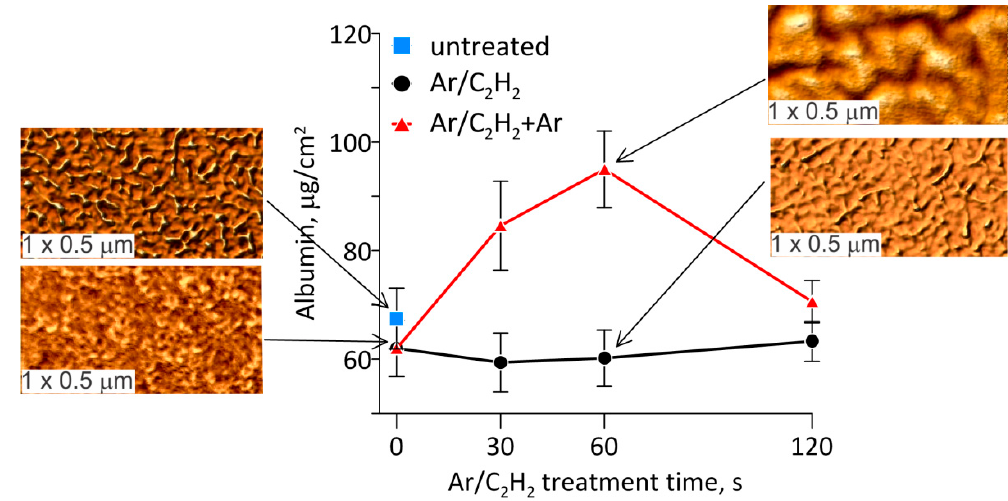
Figure 5. Sorption activity of albumin to the surfaces. The insets show AFM images of surfaces with albumin.